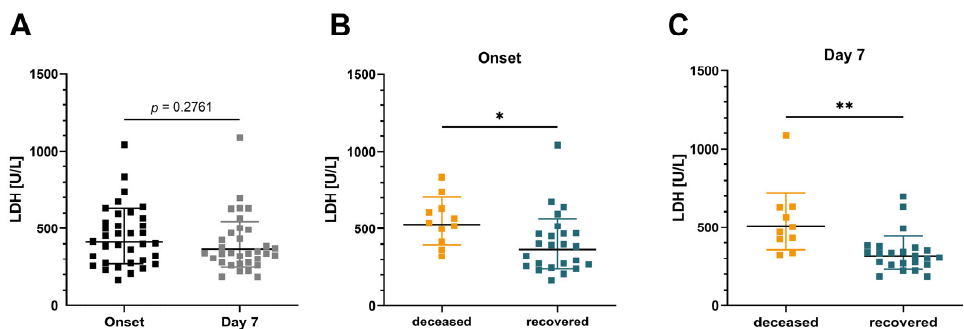
Figure 3. Correlation between LDH levels and the clinical outcome of infection. ( A ) Analysis of LDH values of the paired sample group at onset and day 7. Correlation between the LDH levels and the clinical outcome of infection when assessed at onset ( B ) or day 7 ( C ) of hospitalization. Graphs show the geometric mean and standard deviation. p ‐ values were determined by an unpaired t ‐ test. * p < 0.05, ** p < 0.01.